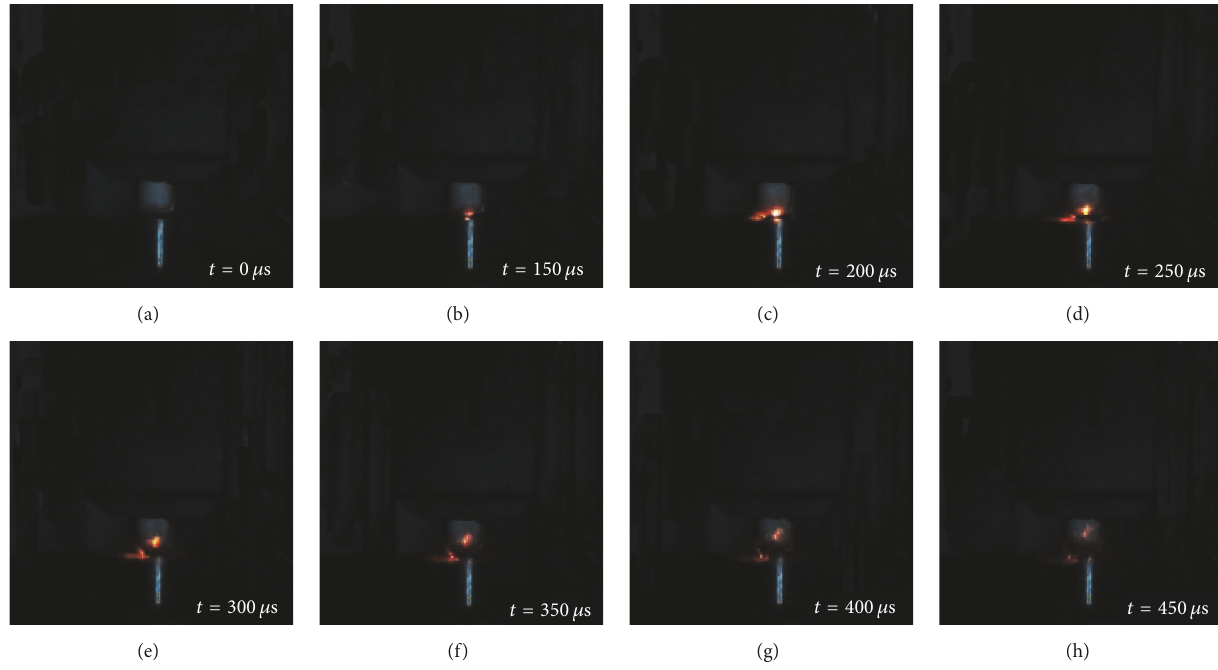
Figure 8: Selected images for a type A specimen reaction recorded by a high-speed camera (from the height of 1.5 m).